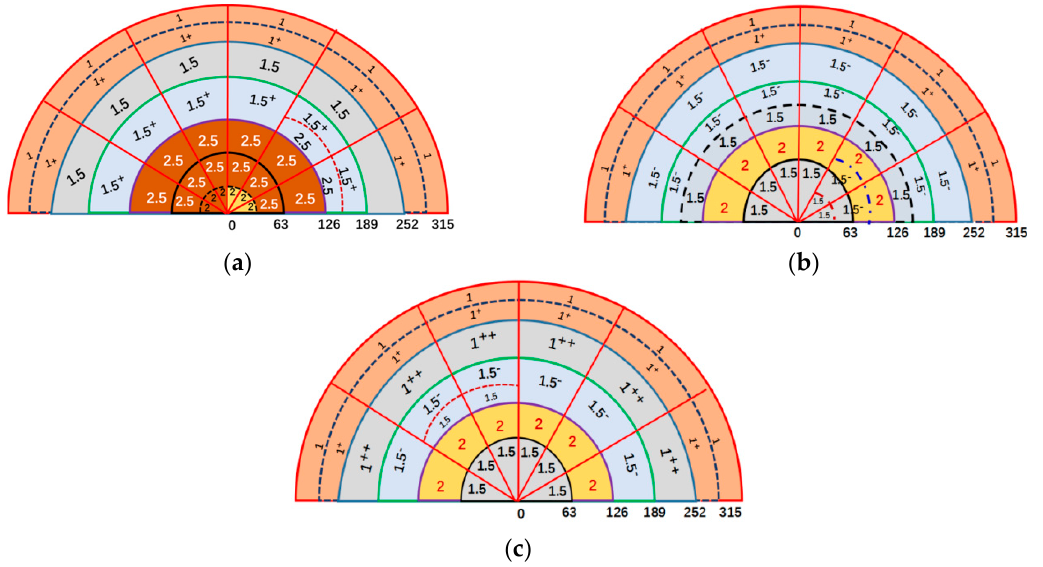
Figure 5. Grain grade diagram of ingots: ( a ) NO-UTS; ( b ) I-UTS; ( c ) L-UTS.